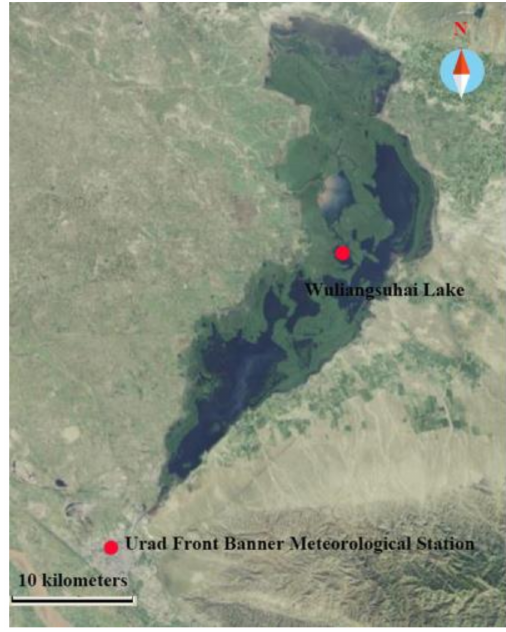
Figure 2. Map of Wuliangsuhai